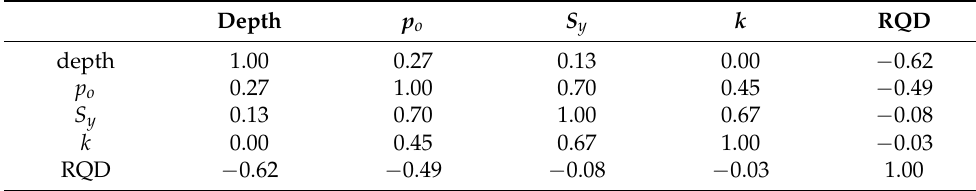
Table 3. Correlation matrix between measured